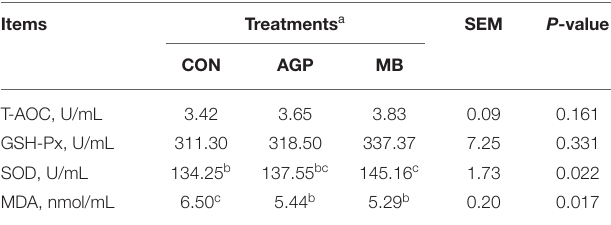
TABLE 3 | Effects of dietary Macleaya cordata extract and Benzoic acid supplementation on serum antioxidant activity of weaned